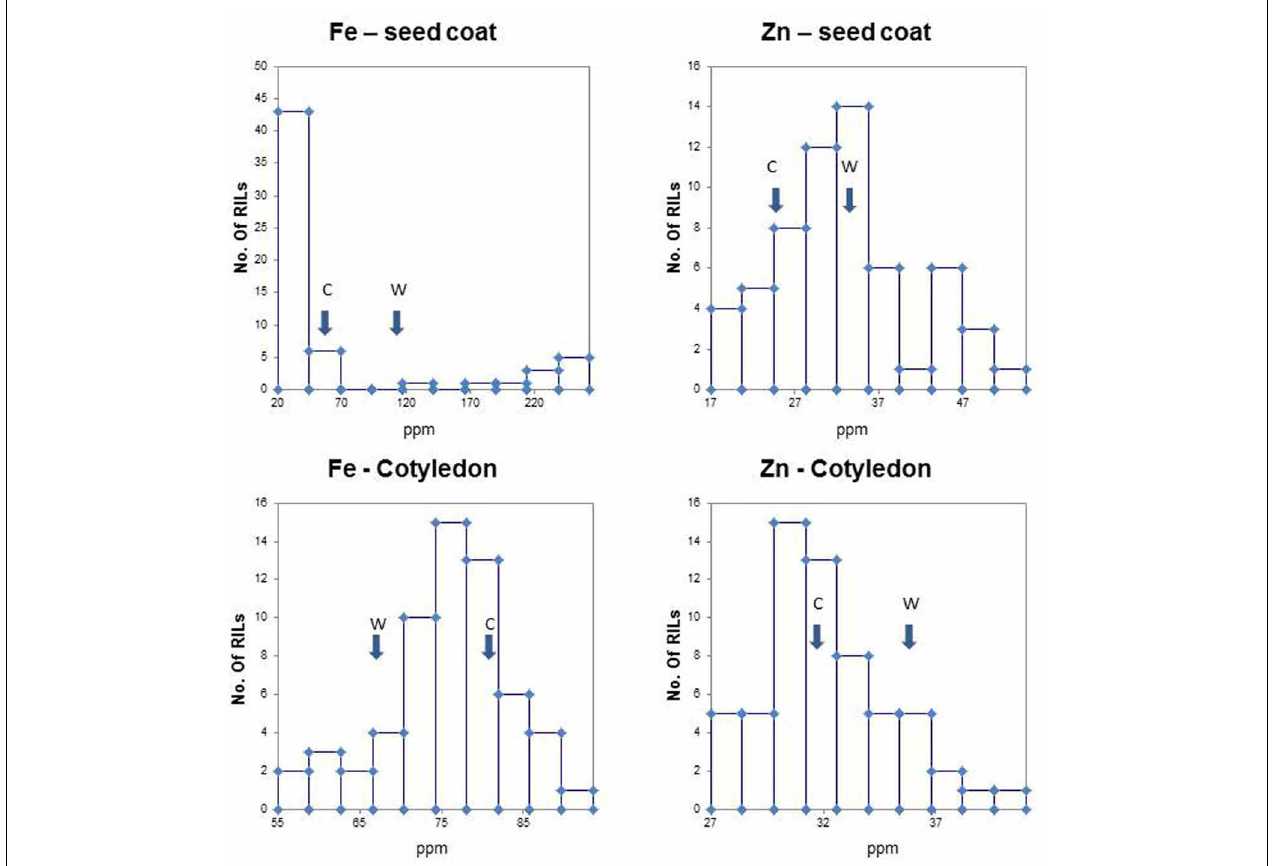
FIGURE 1 | Population frequency distributions for iron (Fe) and zinc (Zn) concentration in seed coats and cotyledonary tissues in the (Cerinza × (Cerinza × (Cerinza × G10022))) advanced backcross population as determined by ICP analysis. Arrows indicate phenotypic